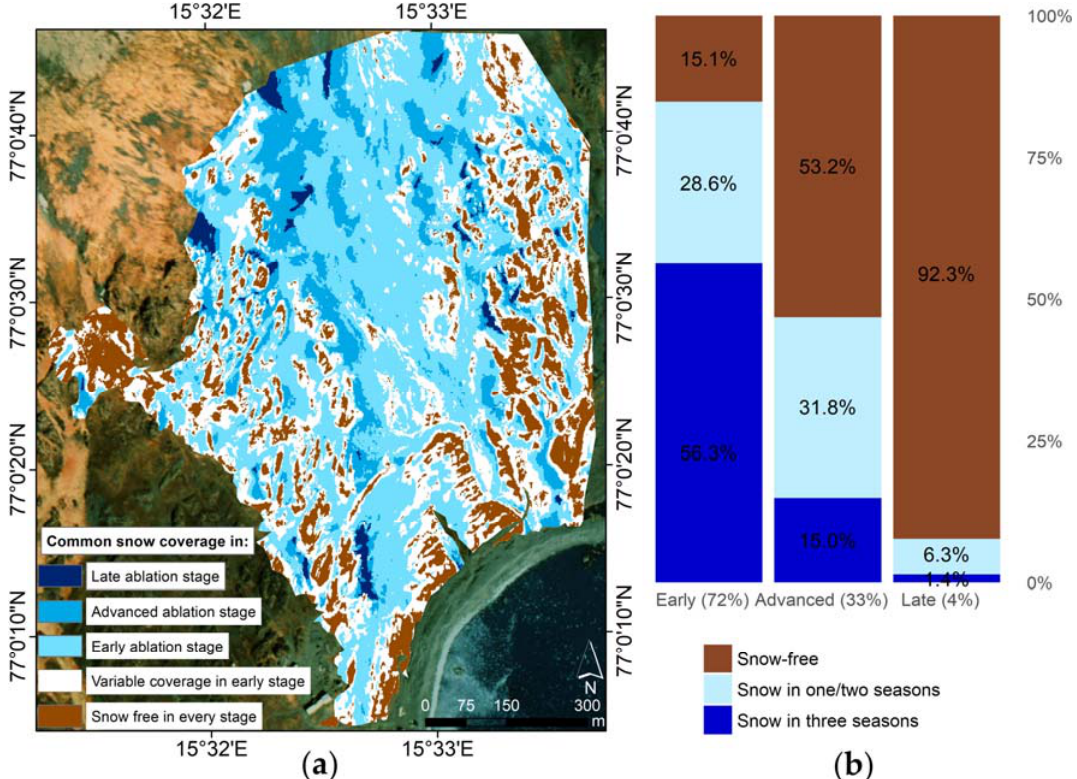
Figure 7. Snow cover distribution in the Fuglebekken catchment based on the 2014–2016 data set in specific melting stages: early (~72% snow coverage), advanced (~33%) and late (~4%). ( a ) Results of SCE superimposition for three years. ( b ) Surface percentage of snow coverage during the three stages.